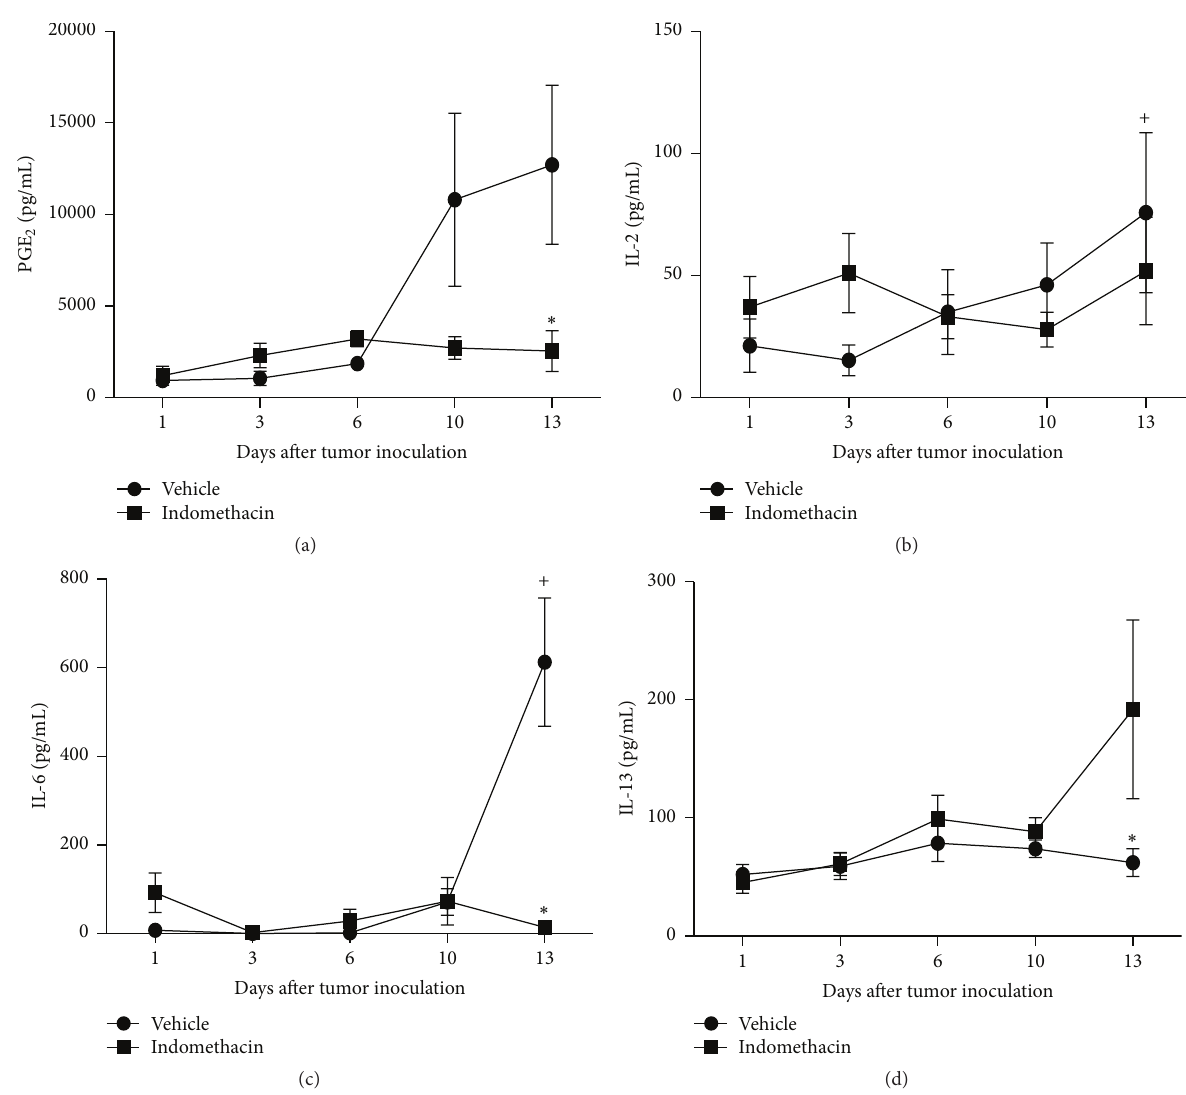
Figure 3: Graphs representing the levels of PGE 2 (a), IL-2 (b), IL-6 (c), and IL-13 (d) present in the peritoneal cavity 1, 3, 6, 10, and 13 days after inoculation of 10 3 EAT cells in mice treated with indomethacin (Indomethacin) or diluent (Vehicle). The groups consist of 6 to 21 animals. The graphs represent the median values obtained for the variables. 𝑃 values are provided as follows: +,∗ 𝑃 < 0.05 , when compared to prior time point in the same experimental group or to the other experimental group in the same time point,